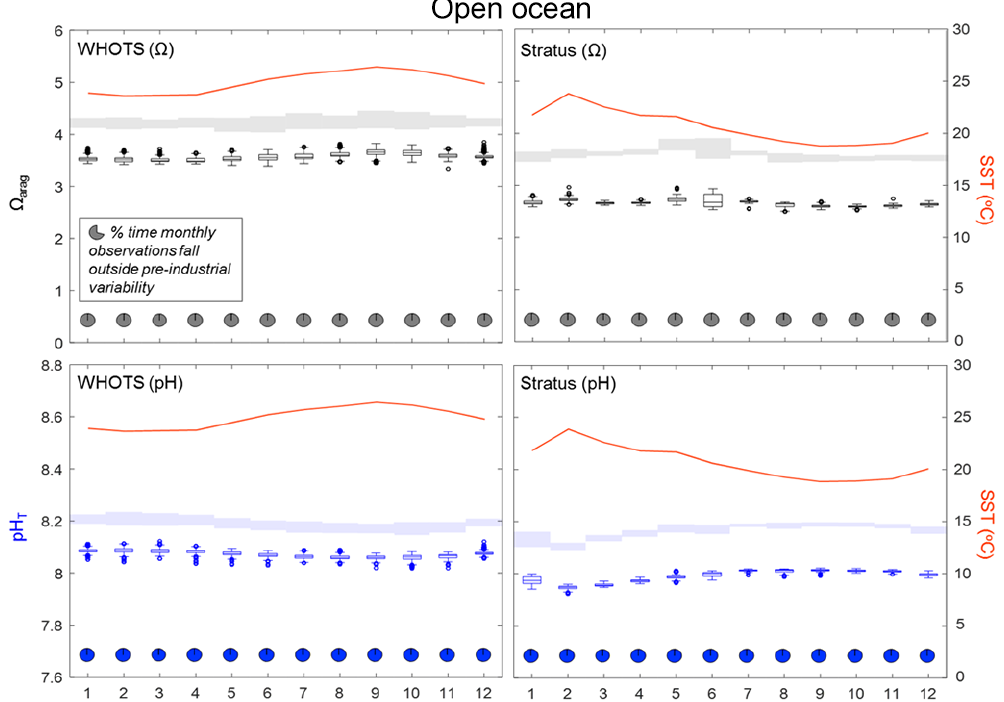
Figure 2. Box and whisker plots of present-day monthly surface seawater (cid:127) arag (top) and pH (bottom) and monthly mean SST (orange lines) at the open ocean mooring locations in subtropical oligotrophic regions (WHOTS, Stratus). Boxes represent data between Q1 and Q3, with the line between representing Q2 (i.e., the median). Whiskers represent 1.5 IQR, or ∼ 2.7SD; Eqs. 1 and 2), of the upper and lower quartiles with data outside that range shown as outliers (open circles). Outliers here represent natural deviations in ocean chemistry, not measurement outliers, which were removed in the data quality control process. Estimated monthly preindustrial (cid:127) arag and pH variability (1.5 IQR or ∼ 2.7SD) is shown in gray (top) and blue (bottom) shaded areas, respectively. Shaded portions of the pie charts indicate the percent of present-day (cid:127) arag and pH values falling outside the bounds of preindustrial variability for each month. For mooring location see Fig. 1 and Table